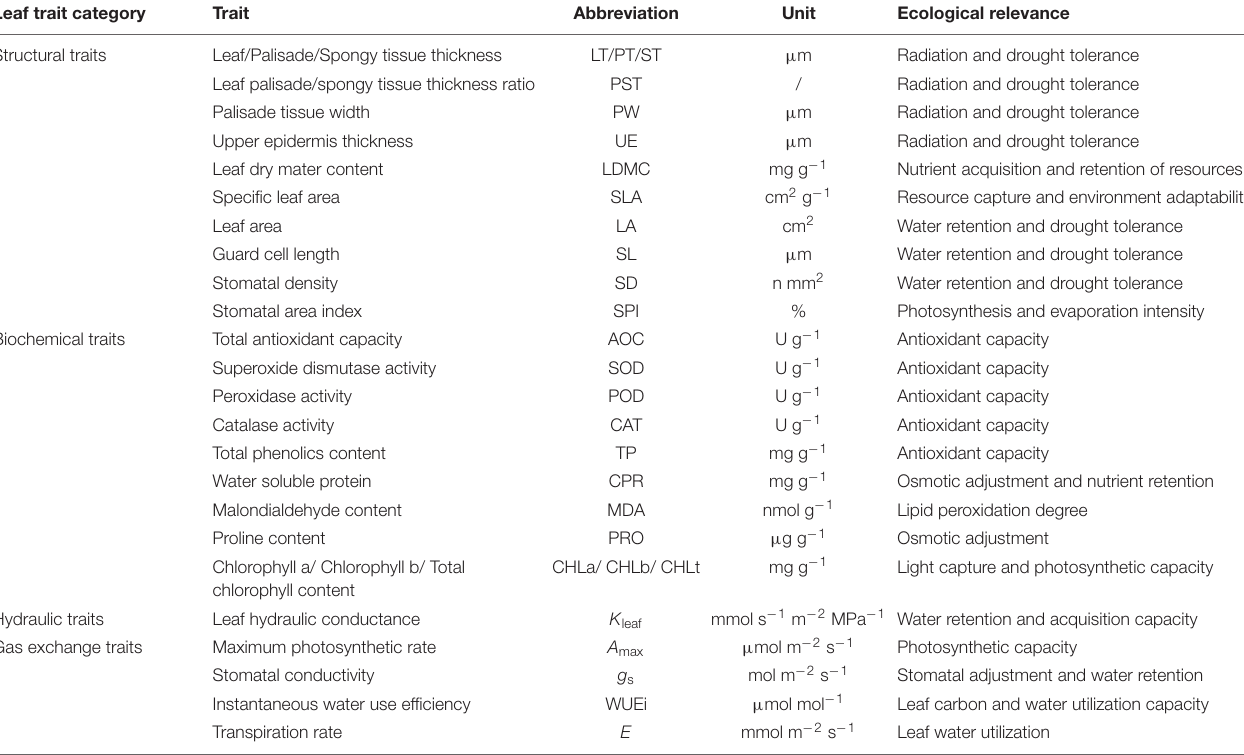
TABLE 1 | Descriptions of the selected plant traits and abbreviations used in this study. Leaf trait